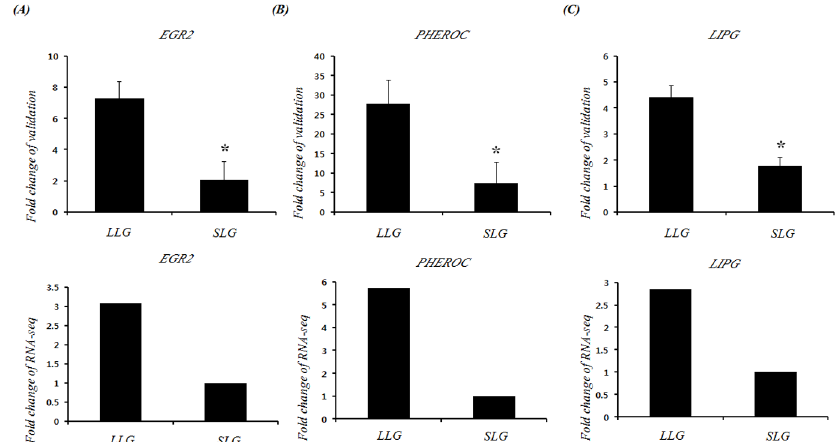
Fig 4. RT-qPCR analysis of EGR2 , PHEROC and LIPG in placental tissue. Three different placentas from LLG and SLG were prepared immediately following delivery and subjected to RT-qPCR analysis. The fold change of validation (upper panel) and RNA-Seq (lower panel) for the (A) EGR2 , (B) PHEROC and (C) LIPG genes are presented. The RT-qPCR data were analyzed by relative quantification using 2 - ΔΔ Ct . Data are expressed as means ± standard deviation (S.D.). Each experiment was performed in triplicate. * , p < 0.05 versus SLG.